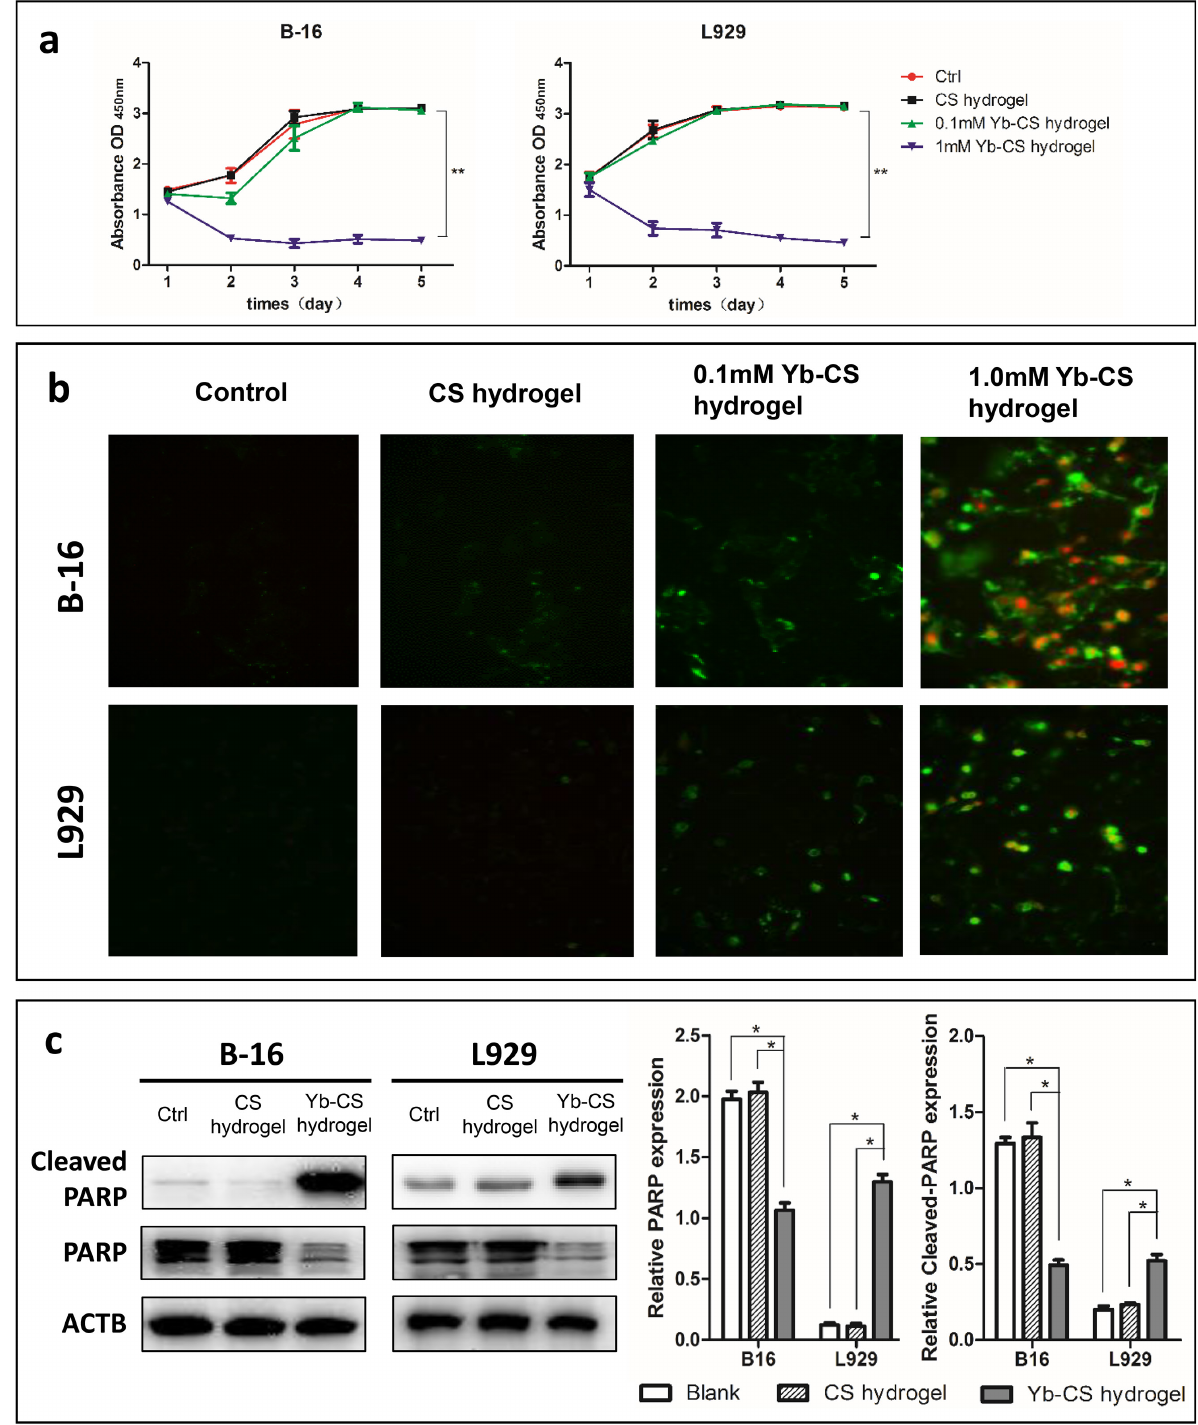
Figure 4: Yb 3+ is the main factor that induces apoptosis in the Yb-CS hydrogel. (a) The absorption values of B-16 and L929 cells decreased in the Yb-CS hydrogel group. (b) Annexin V (green) and PI (red) double staining of B-16 and L929 cells on hydrogels containing Yb 3+ at different concentrations. (c) Western blot of apoptosis marker proteins (PARP and its cleaved form) in B-16 and L929 cells treated with no hydrogels (control), blank CS hydrogels and Yb-CS hydrogels. *p < 0.05, **p <